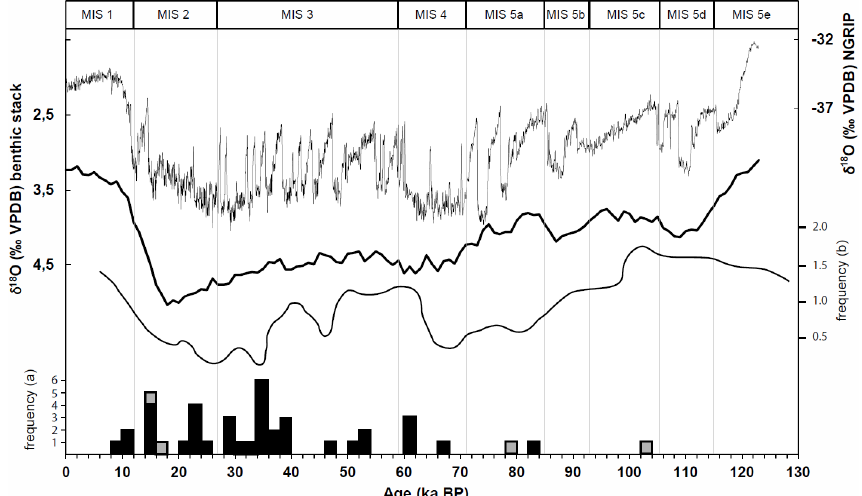
Fig. 4. Frequency distribution of 42 230 Th/U age determinations of coarsely crystalline CCC from Germany, the Czech Republic, Slovakia and Poland for the last 130ka. Age data from Table S1 in the Supplement are shown as histogram with 2ka intervals. CCC ages of samples Figure 4. Frequency distribution of 41 230 Th/U-age determinations of coarsely crystalline 15 from high-altitude caves showing present temperature below 4 ◦ C are shown as grey squares, other data as black squares (a) . The northwestern CCC from Germany, the Czech Republic, Slovakia and Poland for the last 130 ka. Age data 16 Europe common speleothem and travertine growth frequency record (b) is after Baker et al. (1993). The stacked benthic O isotope record of Lisiecki and Raymo (2005) (thick line) serves as a reference curve for global glacial–interglacial climate variability. For the Northern from Table 1 are shown as histogram with 2 ky intervals. CCC ages of samples from high-17 Hemisphere climate, the NGRIP record is shown (North Greenland Ice Core Members, 2004; thin line). Time boundaries of marine oxygen altitude caves showing present temperature below 4 °C are shown as grey squares, other data 18 isotope stages shown in the uppermost part of the figure are after Wright (2000), with some later